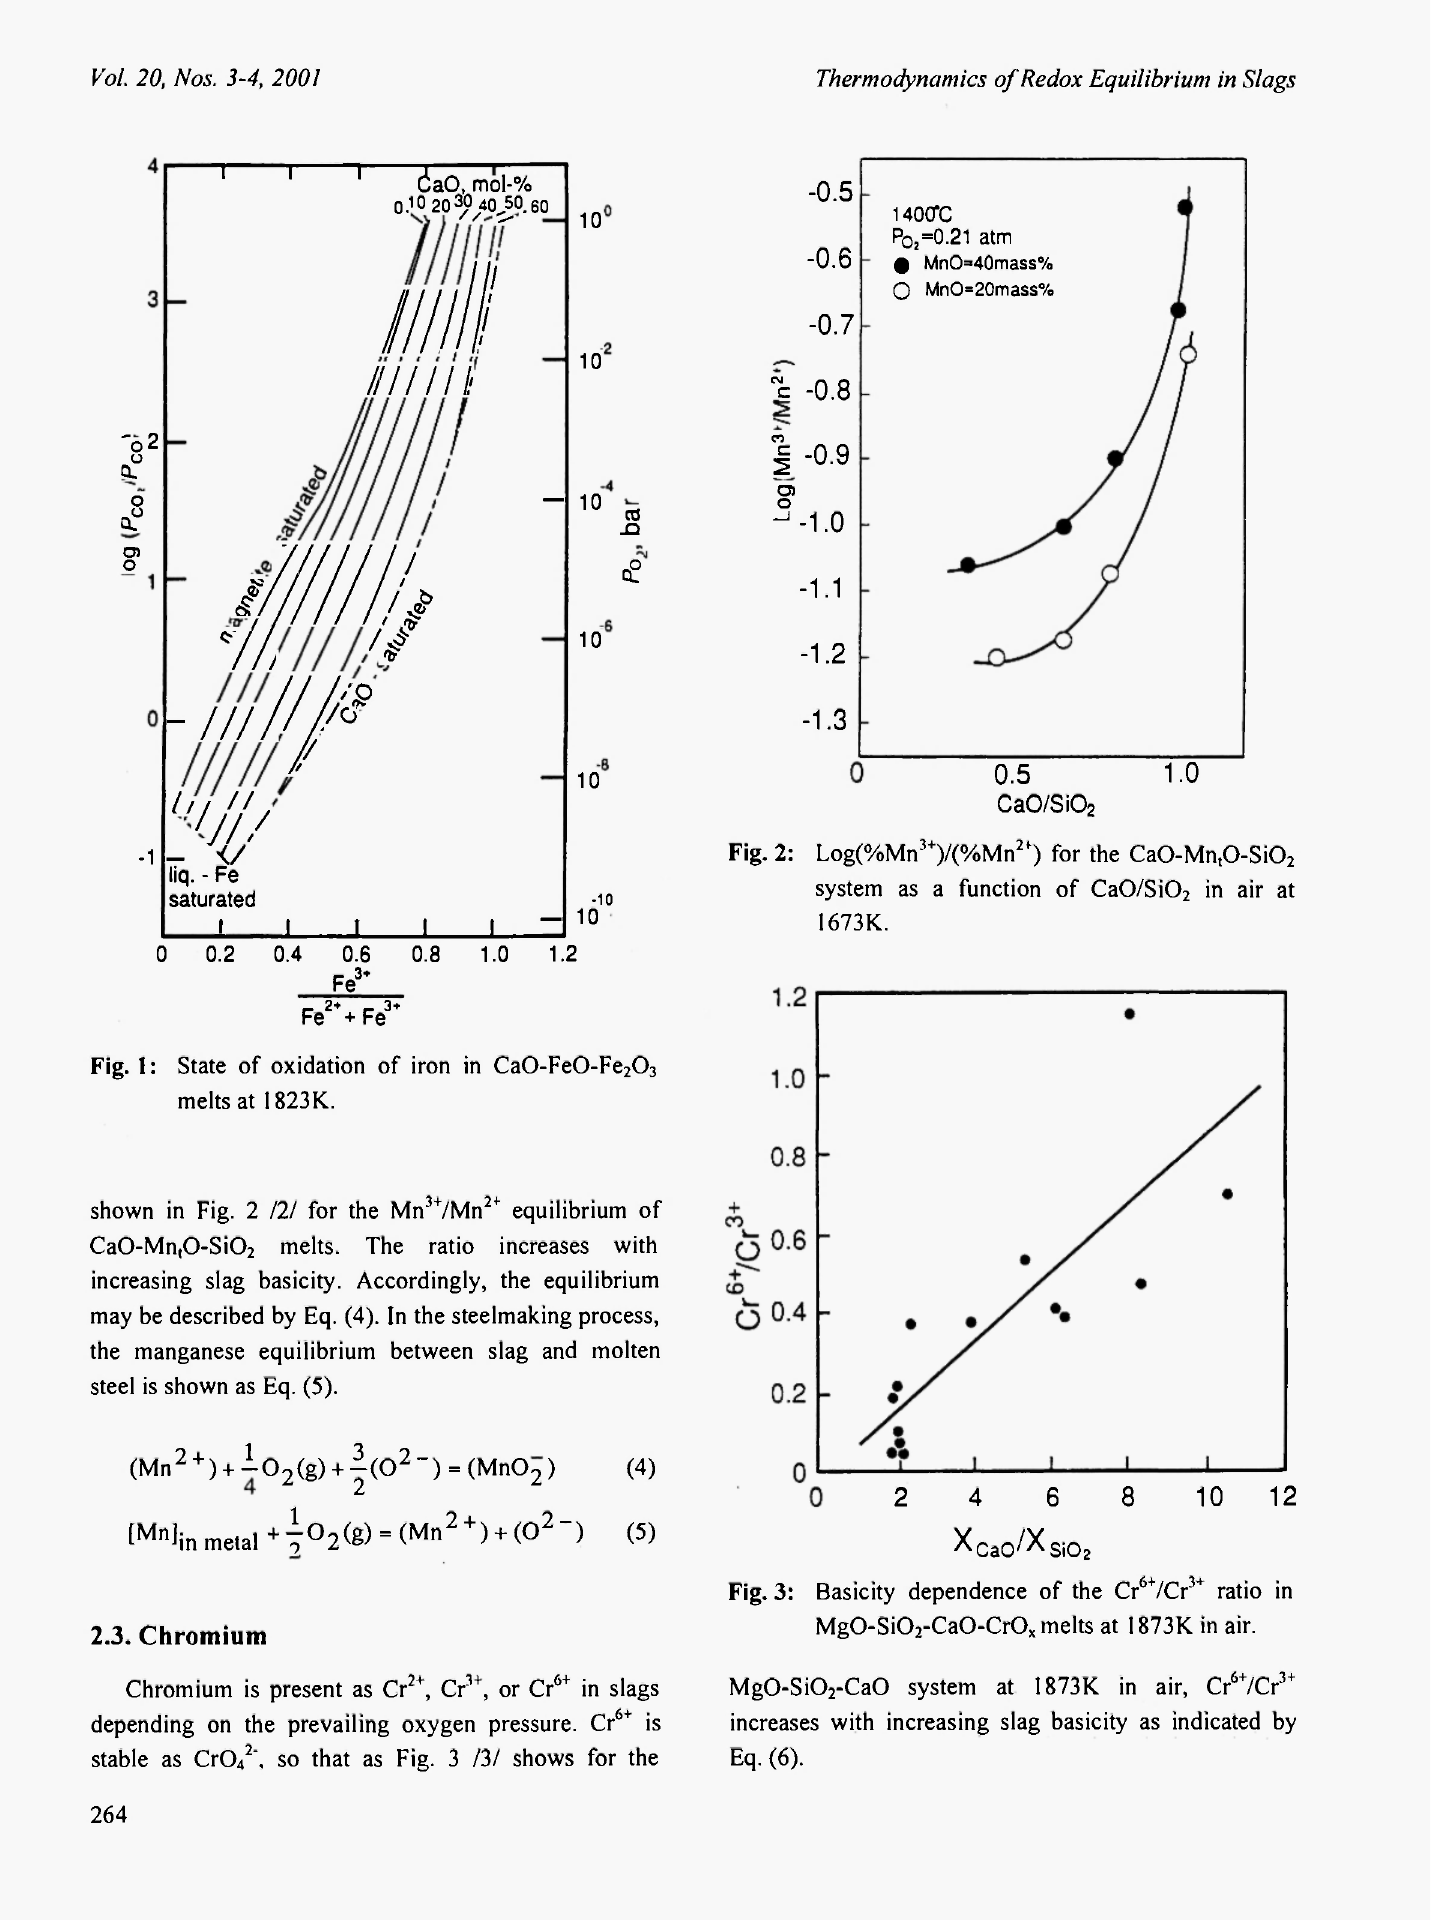
Fig. 1: State of oxidation of iron in Ca0-Fe0-Fe 2 0 3 melts at 1823K.